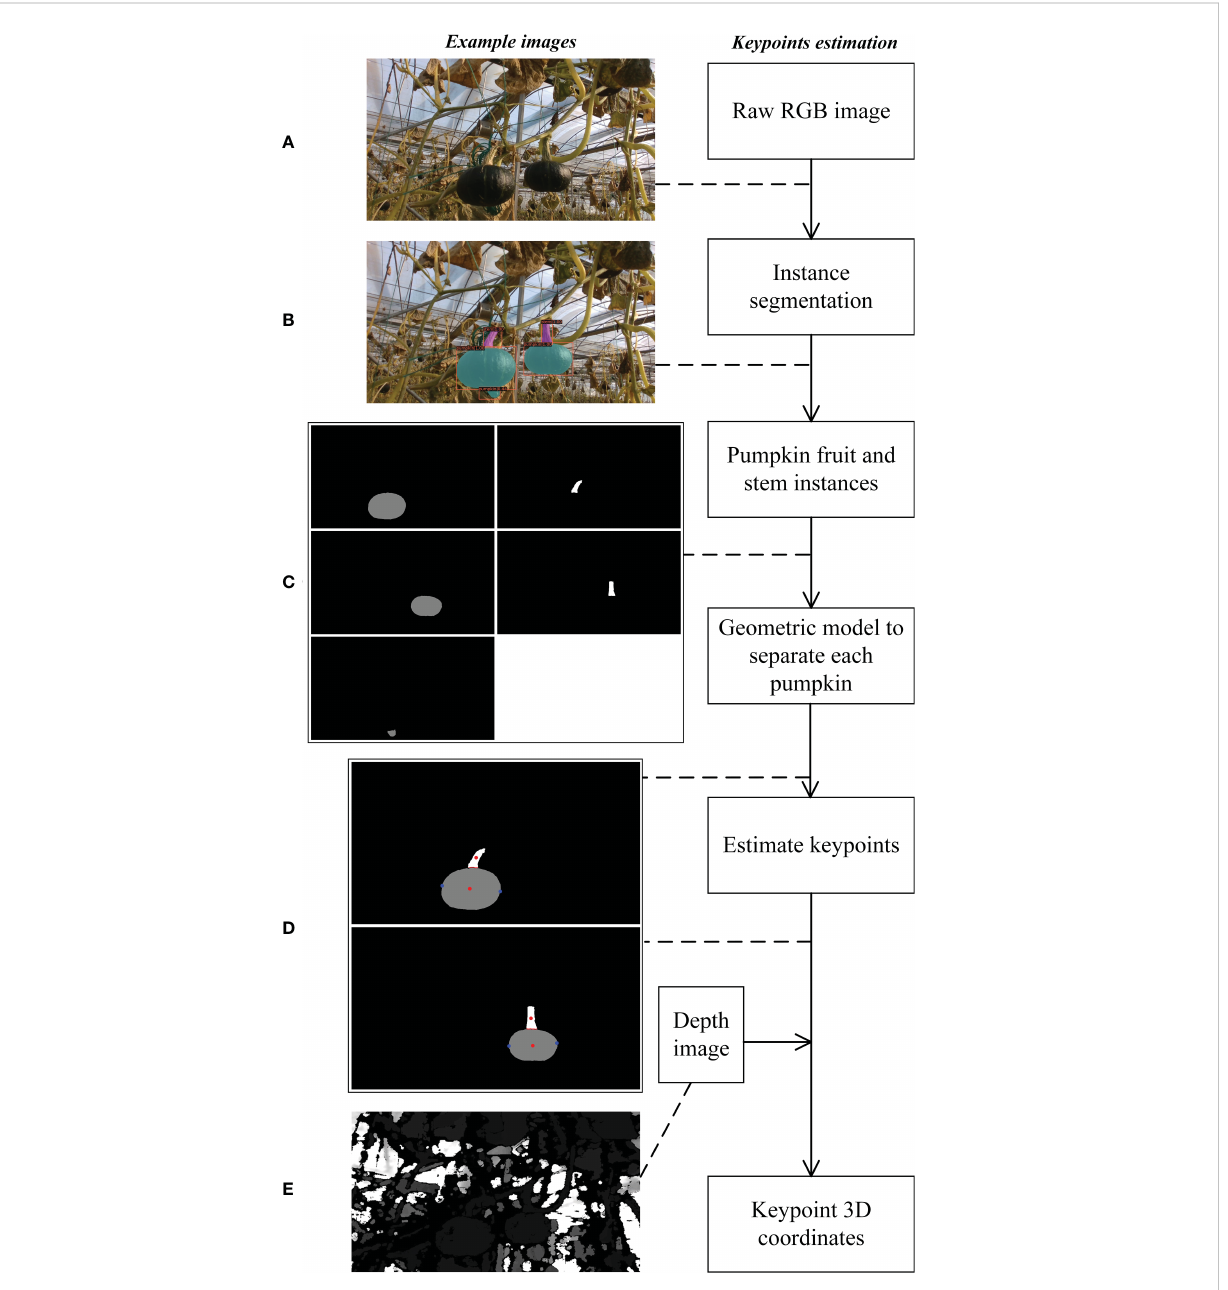
FIGURE 8 Block diagram of cutting and grasping point estimation method along with example images. (A) Pumpkin RGB image. (B) Pumpkin fruit and stem instance segmentation result. (C) Visualization of pumpkin fruit and stem instances. The left column instances are fruits, and the right column instances are stems. (D) The separate pumpkins with keypoints. The red points between the stem and the fruit are adjacent points. The red dot in the stem is the cutting point, and the blue points in the fruit are the grasping points. (E) Pumpkin depth image. Best viewed zoom